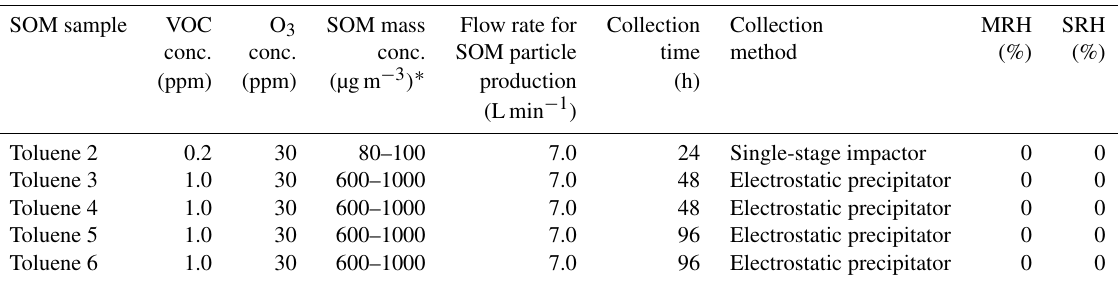
Table 2. Experimental conditions for production and collection of SOM produced by photo-oxidation. Included are the measured separation relative humidity (SRH) upon moistening and mixing relative humidity (MRH) upon drying of the collected particles. Particles were collected on hydrophobic substrates using an electrostatic precipitator or single-stage impactor. SRH = 0 and MRH = 0 indicate LLPS was not observed during humidity cycles. SOM sample VOC O 3 SOM mass Flow rate for MRH SRH conc. conc. conc. SOM particle time method (%) (%) (ppm) (ppm) (µgm − 3 ) ∗ production (h) (Lmin − 1 ) Toluene 2 0.2 Toluene 3 1.0 Toluene 4 Toluene 5 Toluene